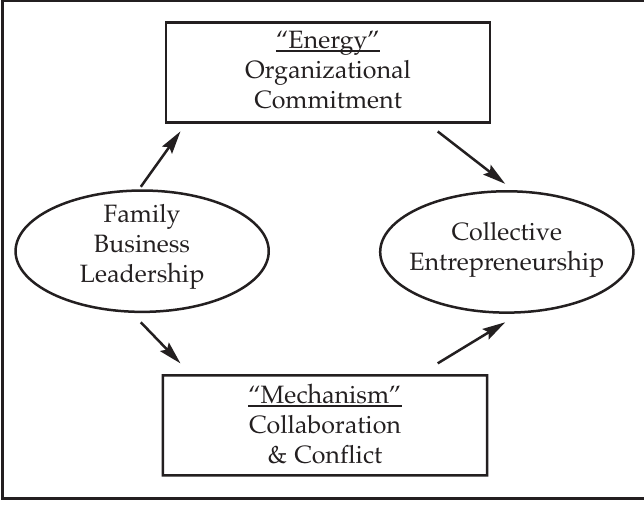
Figure 1. Leadership, “Energy,”